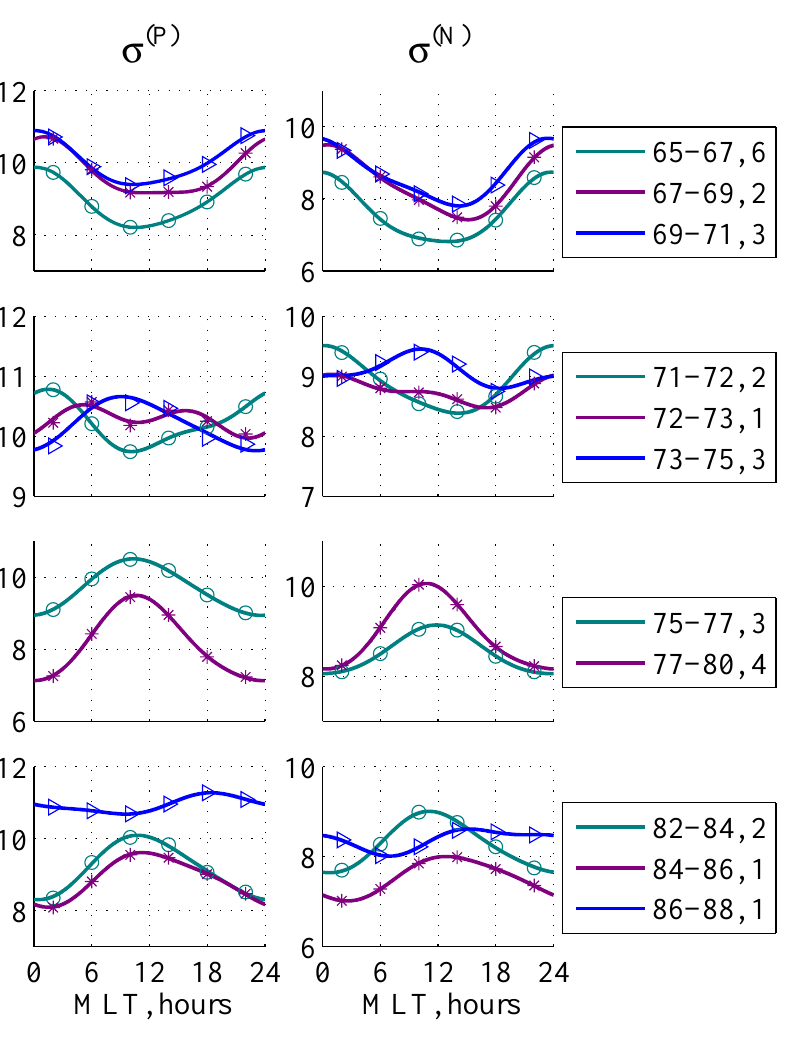
Fig. 3. Diurnal variations of the logarithm of the spectral power σ , averaged over CGM latitude 8 , and their approximations according to Eq. (6) at K = 2. Observed values are given with markers, and lines show the results of approximation. Boundaries of zones and number of stations are given at the